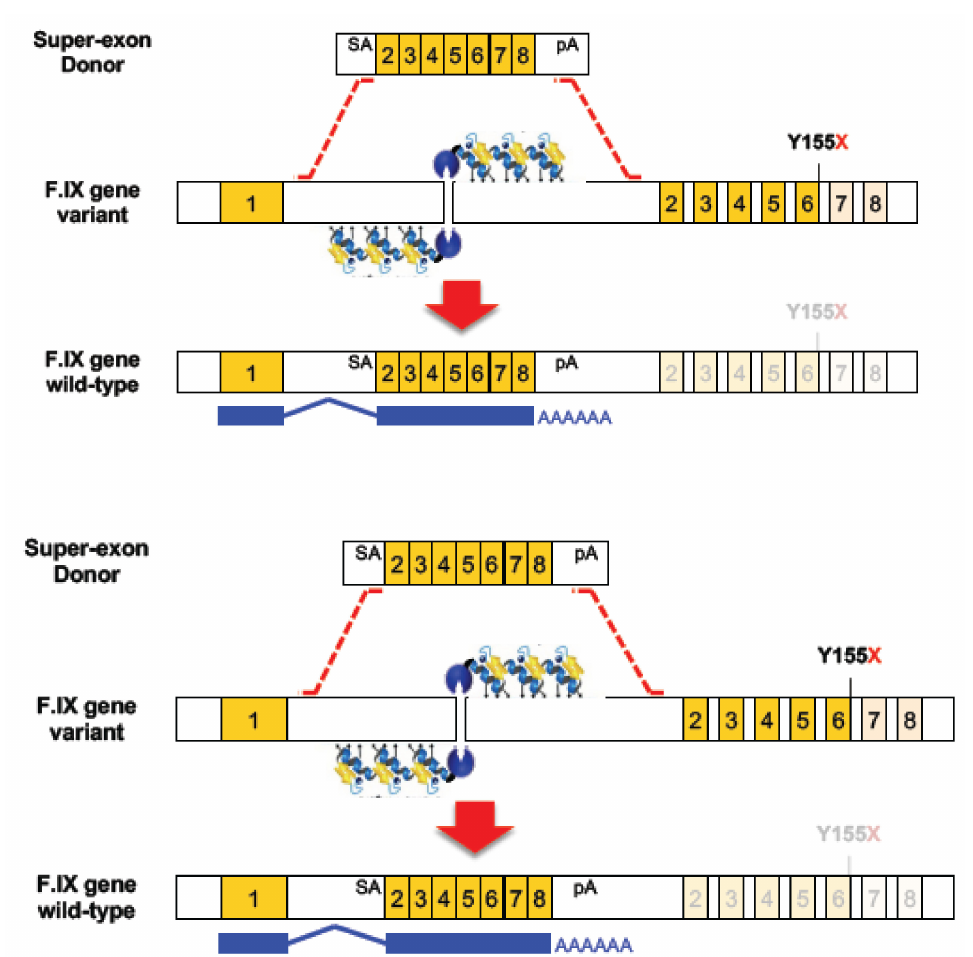
Figure 1. Schematic overview of zinc finger nuclease (ZFN)-mediated homology-directed repair (HDR). Upper panel: superexon donor with homology arms, SA, exons 2–8 fused as partial cDNA and poly A. Middle panel: ZFNs create DSB in intron 1 which triggers strand invasion of donor leading to HDR. Lower panel: superexon incorporated into the genome such that mRNA splices from endogenous exon 1 to superexon 2–8. The expression of the corrected mRNA is driven by the endogenous promoter. Adapted from